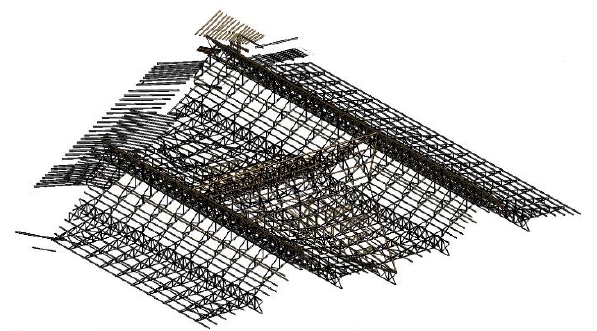
Figure 7. System of trusses and beams